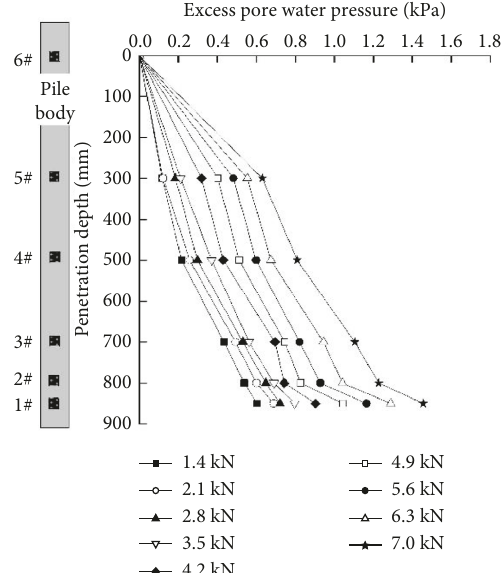
Figure 9: Change in excess pore water pressure of test pile TP2 with depth under various